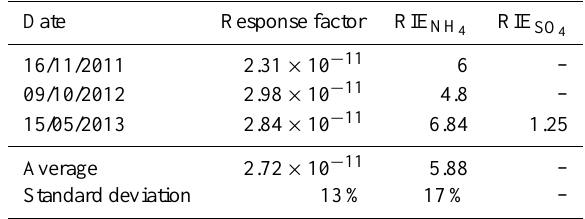
Table 1. Response factors obtained through IE calibrations